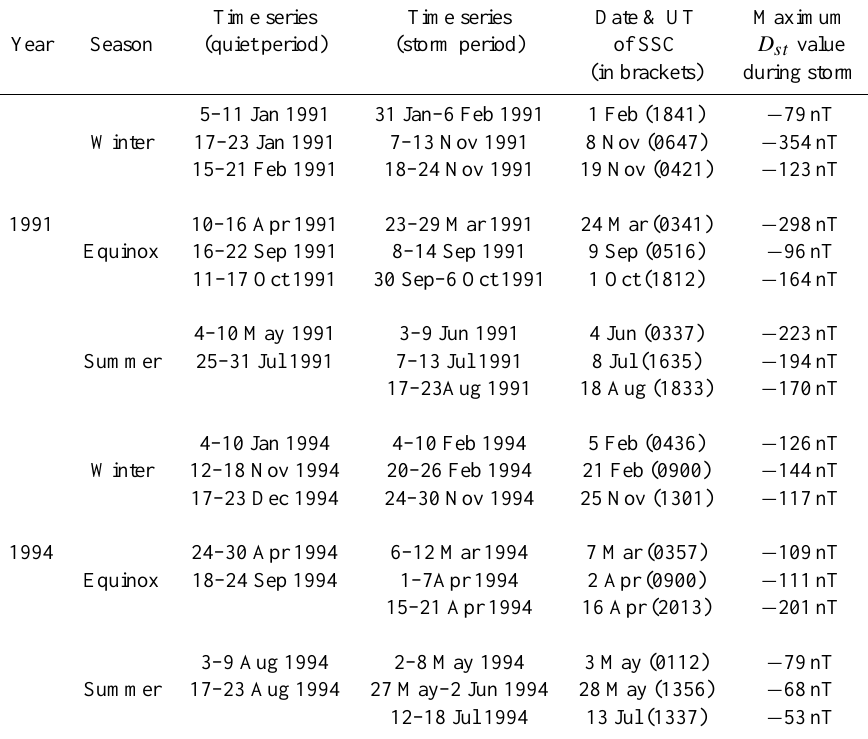
Table 1. List of time series of AE index considered for this study, representing quiet periods and storm periods with date, time of storm sudden commencement (SSC), and maximum value of D st during storm. Time series Time series Date & UT Maximum Year Season (quiet period) (storm period) of SSC D st value (in brackets) during